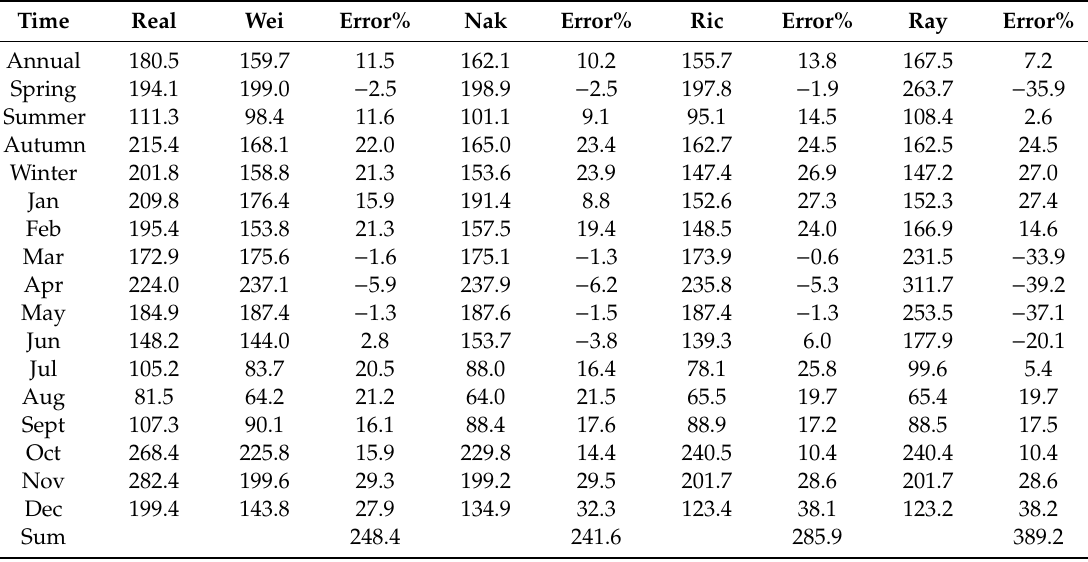
Table 13. Evaluation of the errors between the observed and forecasted